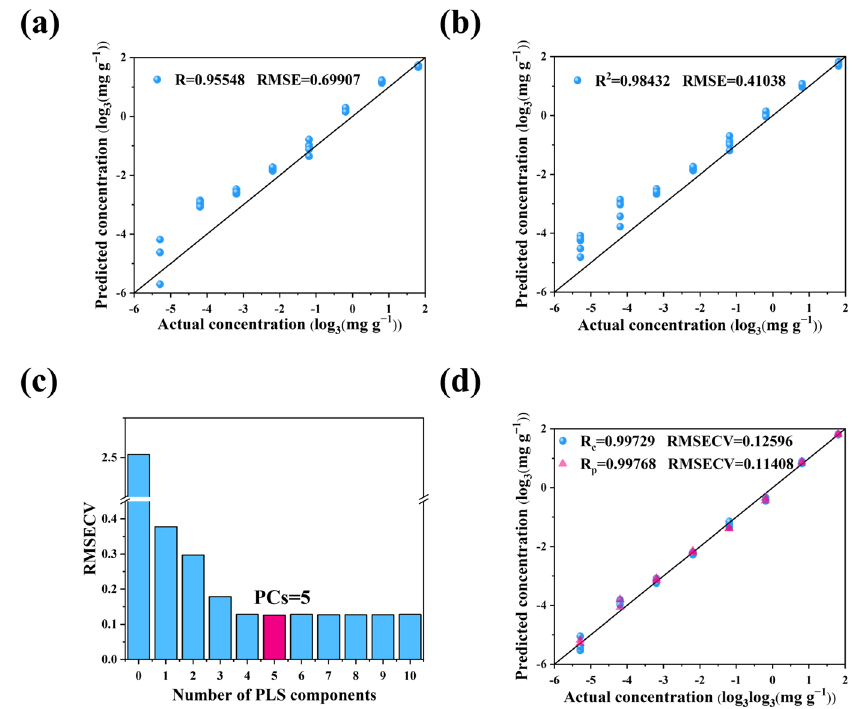
Figure 8. Analytical results of models. Scatter plots of predicted concentration (log 3 (mg·g −1 )) versus actual concentration (log 3 (mg·g −1 )) for ULR ( a ), MLR ( b ), and PLS ( d ) models. ( c ) RMSECV versus PLS components for the PLS model.